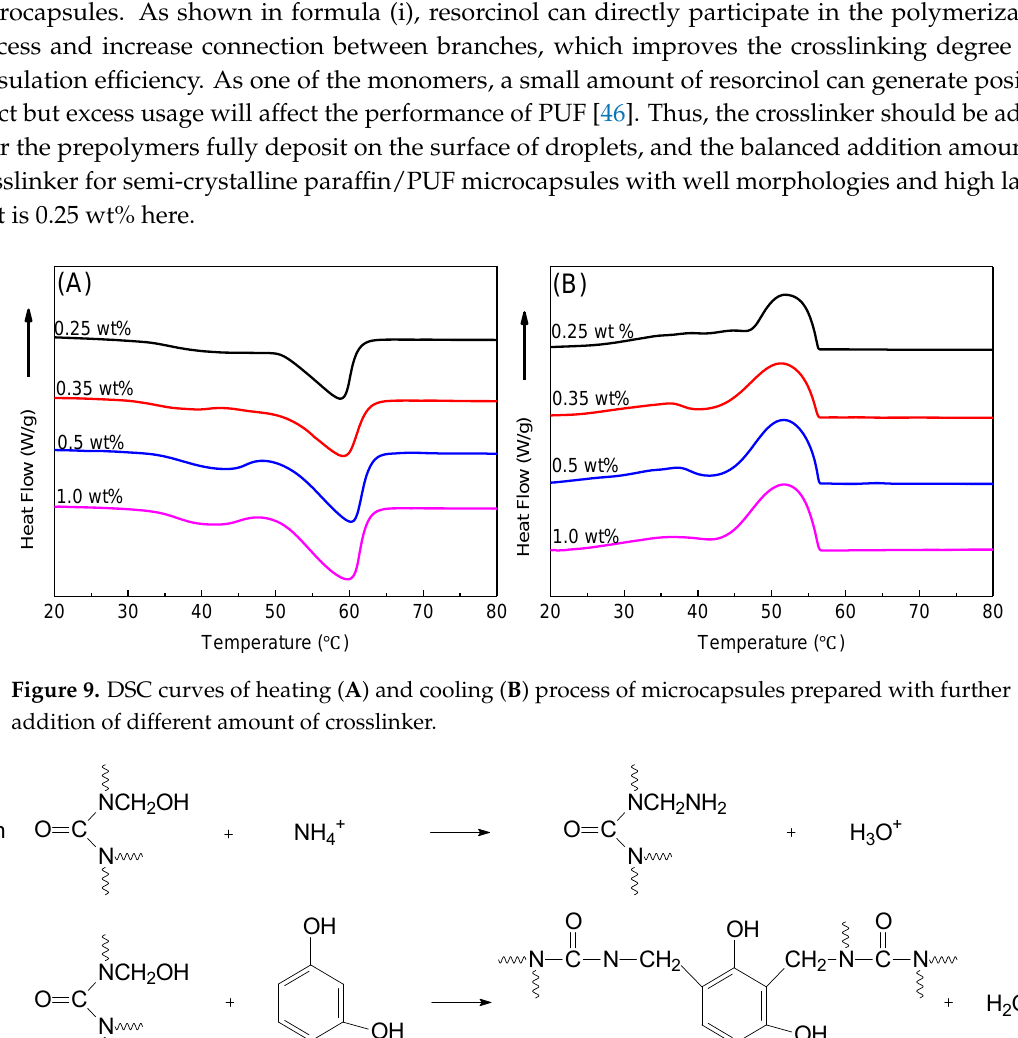
Figure 8. SEM images of microcapsules prepared with different amount of crosslinker. 0.25 wt% ( A ), 0.35 wt% ( B ), 0.5 wt % ( C ), 1 wt% ( D ). The scale bars are all 10 μm.